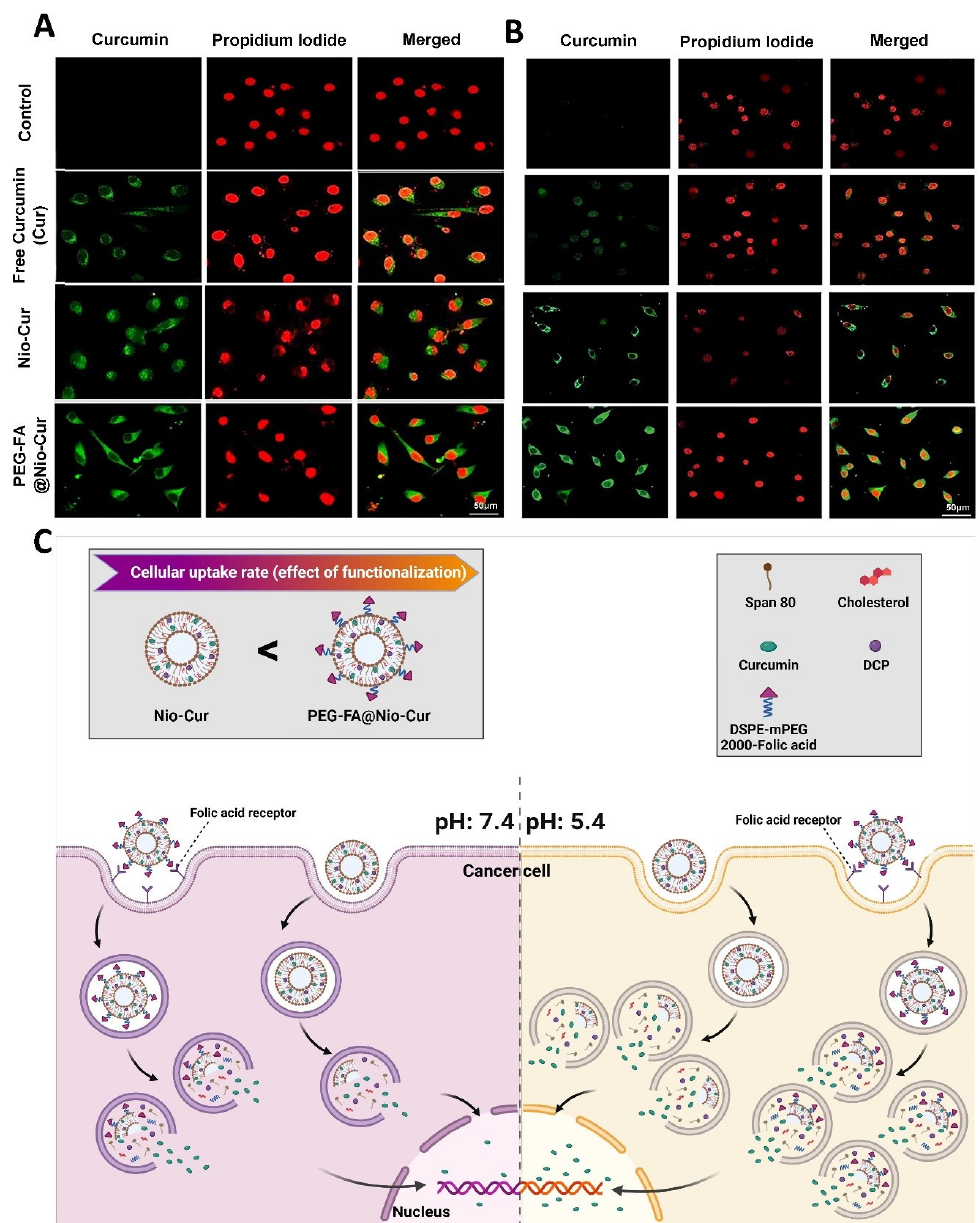
Figure 8. ( A , B ) Uptake of niosomes into MCF7 ( A ) and 4T1( B ) cells was investigated with confocal laser scanning microscopy. The niosomes investigated were Cur, Nio-Cur, and PEG-FA@Nio-Cur; the nucleus was stained with propidium iodide (red). Curcumin shows green fluorescence; ( C ) schematic depicting the effect of pH on the release of contents from a niosome.